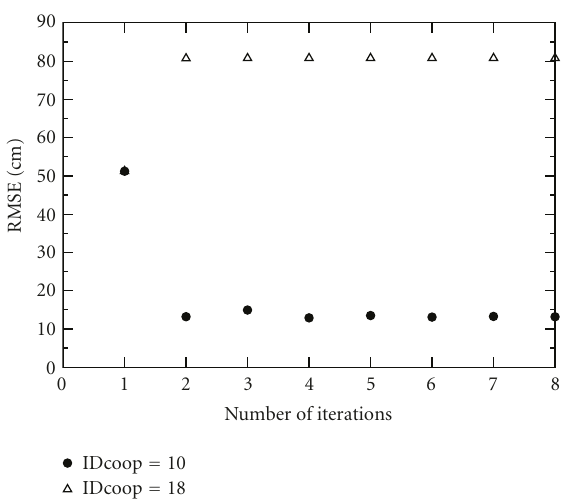
Figure 8: RMSE as a function of number of iterations when target 1, located in position 8, cooperates with target 2, in position 10 or 18. N = 3 (tx1,tx3,tx5) beacons are considered. Tx5 is taken as reference for the LS algorithm.